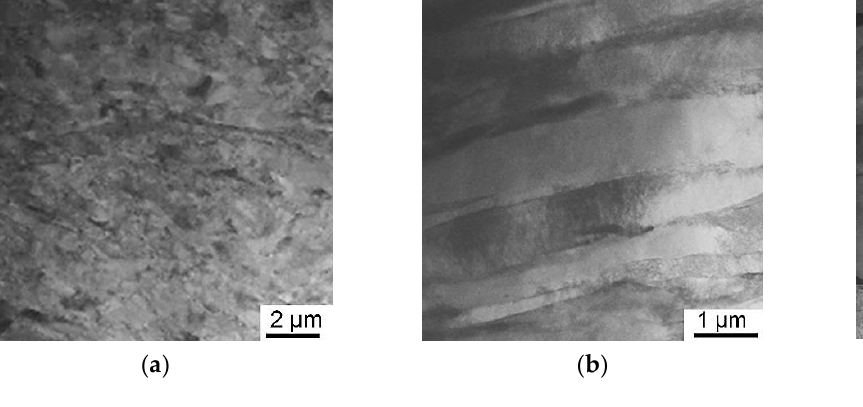
Figure 3. STEM images of the microstructure of the Ti-6Al-4V samples subjected to UIT. The mi- crographs were obtained at a depth of 5 ( a ), 45 ( b ) and 75 µm below the treated surface ( c ).